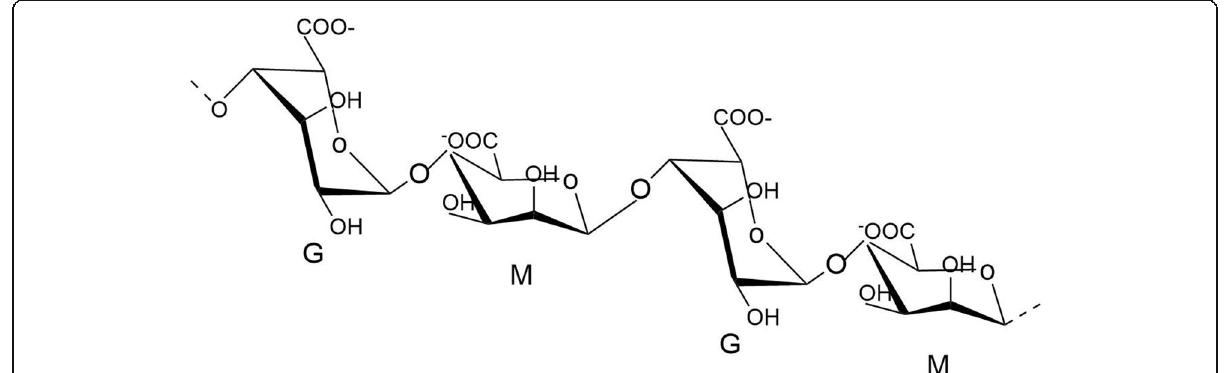
Fig. 1 Structure of sodium alginate: M, mannuronic acid; G, guluronic